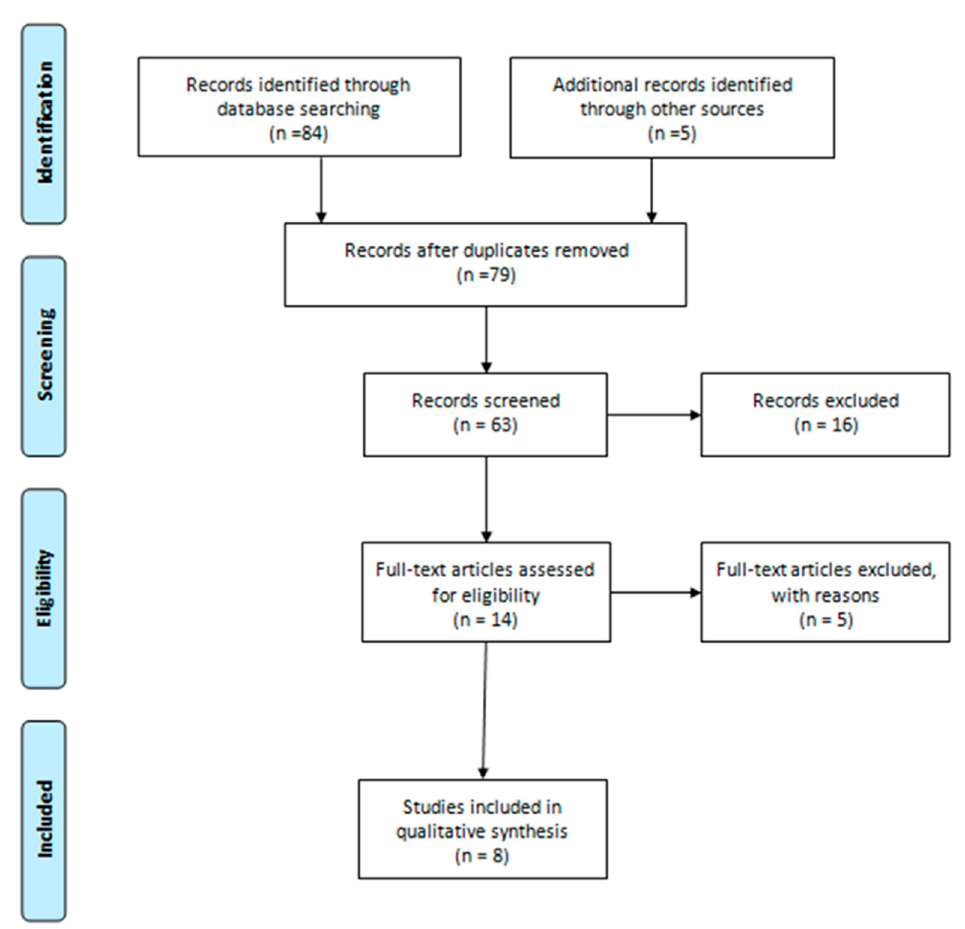
Figure 1. Flowchart of the selection of the base body of study.